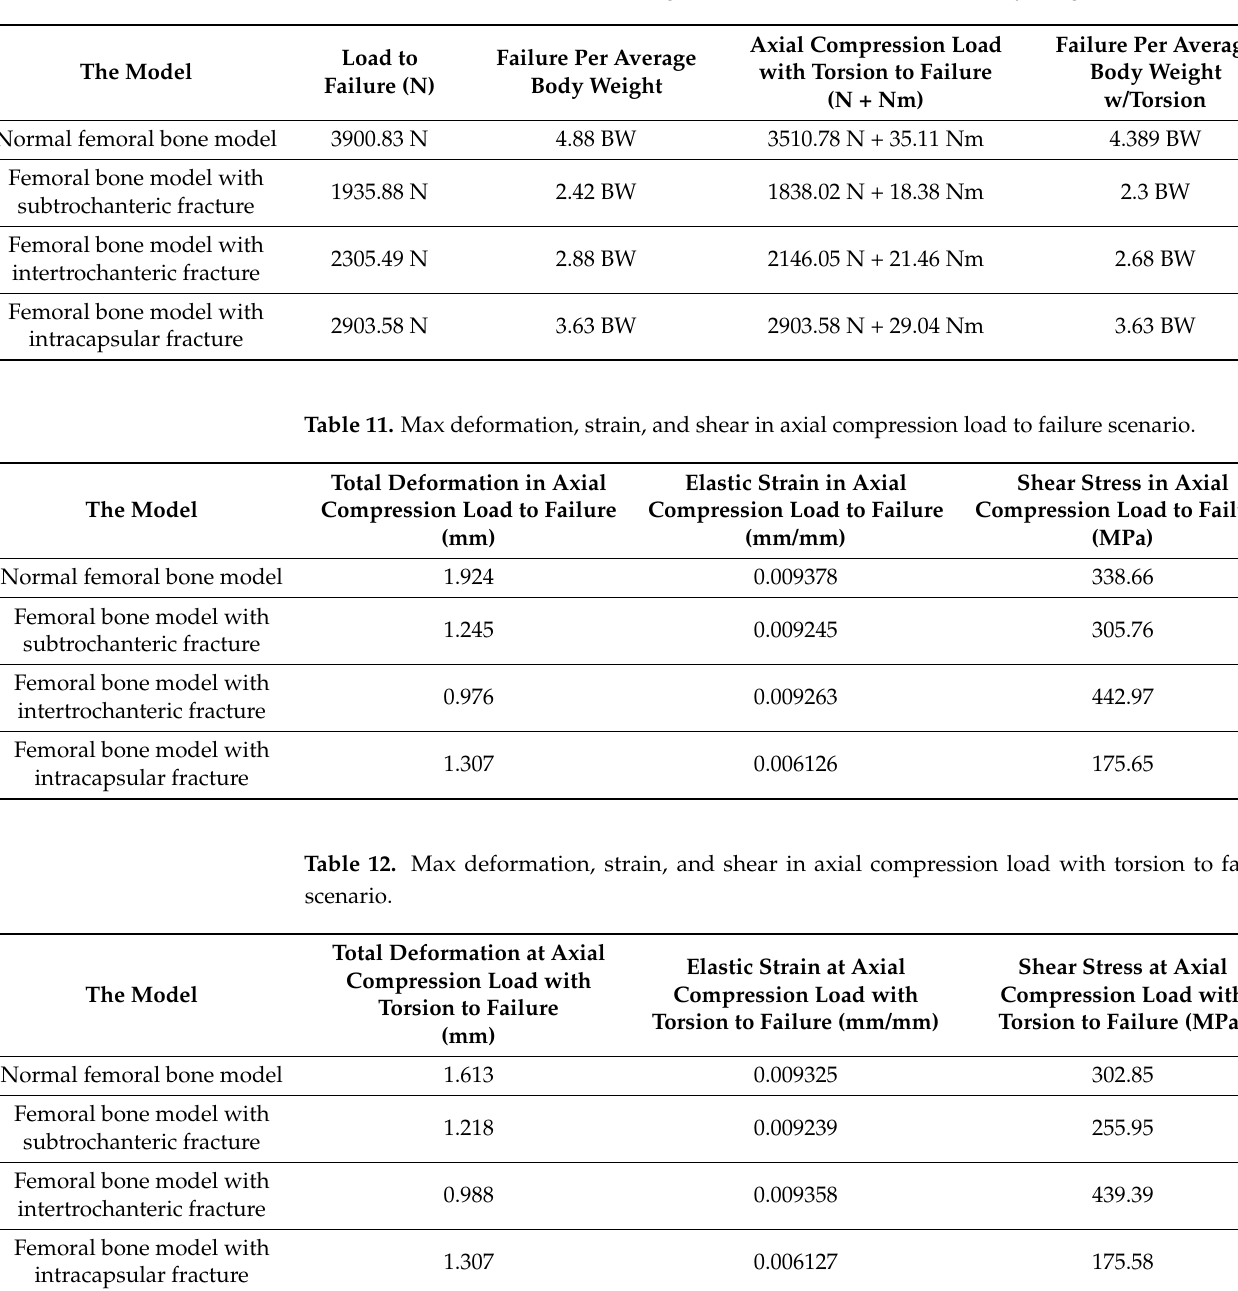
Table 10. Max stress from the loading simulations, where BW is the body weight.